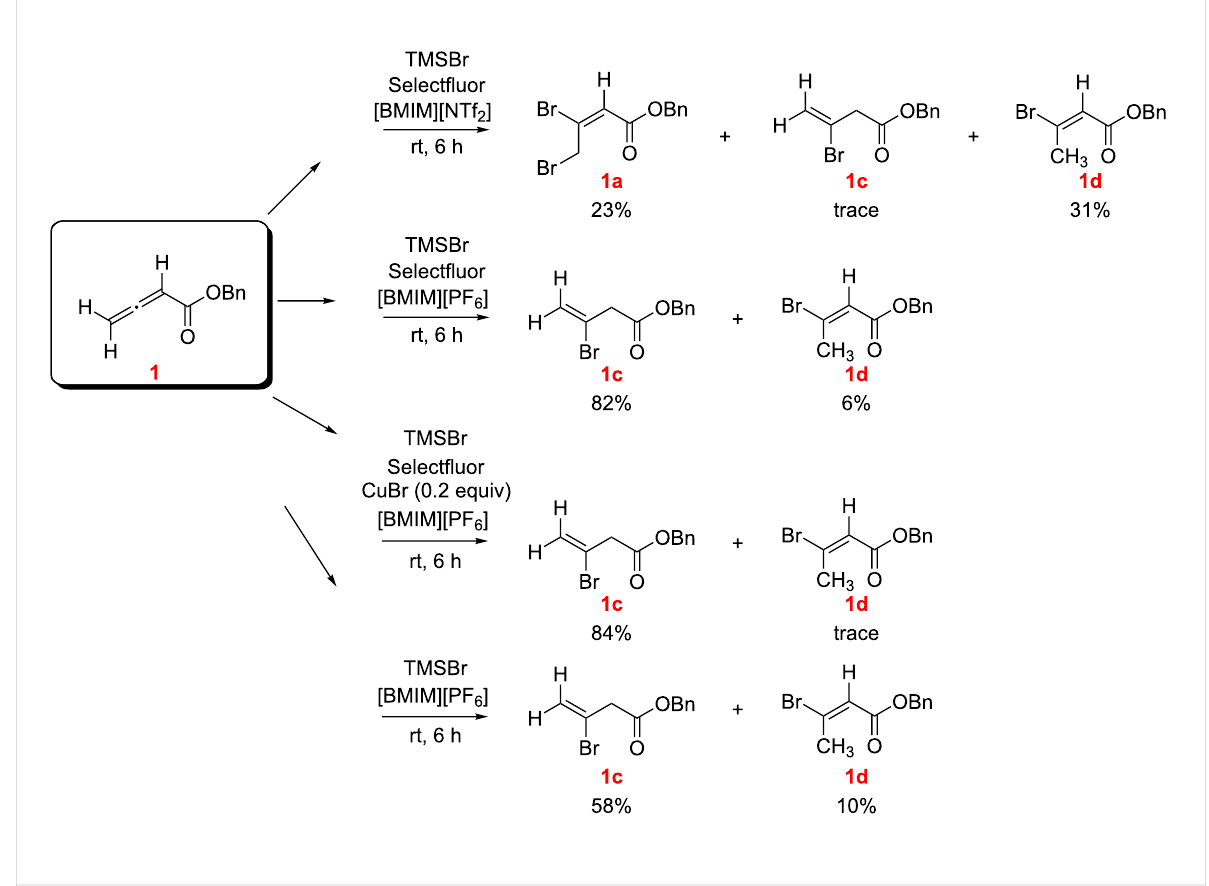
Scheme 2: Reaction of benzyl allenoate ( 1 ) with TMSBr with and without Selectfluor in IL solvents ( E/Z designations, as illustrated, were made by NMR; see Supporting Information File 1).